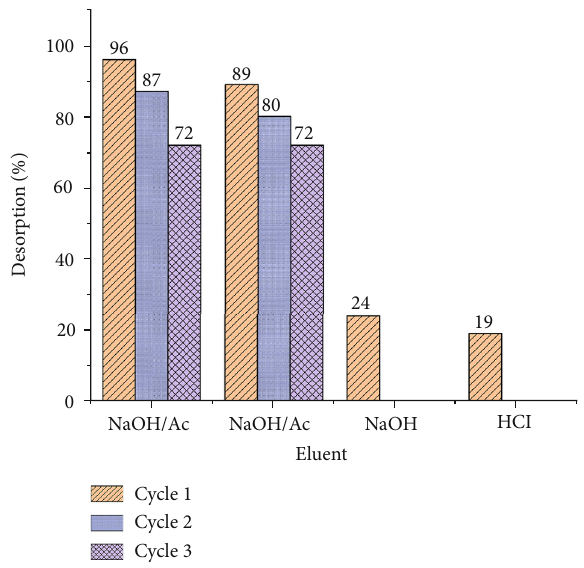
Figure 10: Desorption percentage of CV from PACK after three cycles using solvent mixtures (NaOH/acetone or HCl/acetone) or single solvent (NaOH or HCl; only cycle one